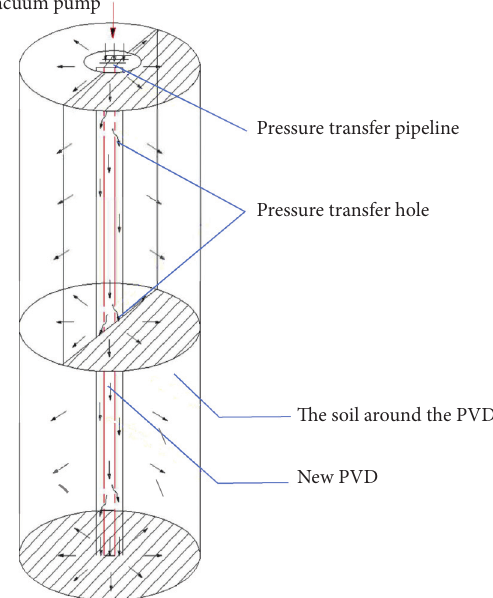
Figure 10: Transfer of vacuum pressure along the new PVD.